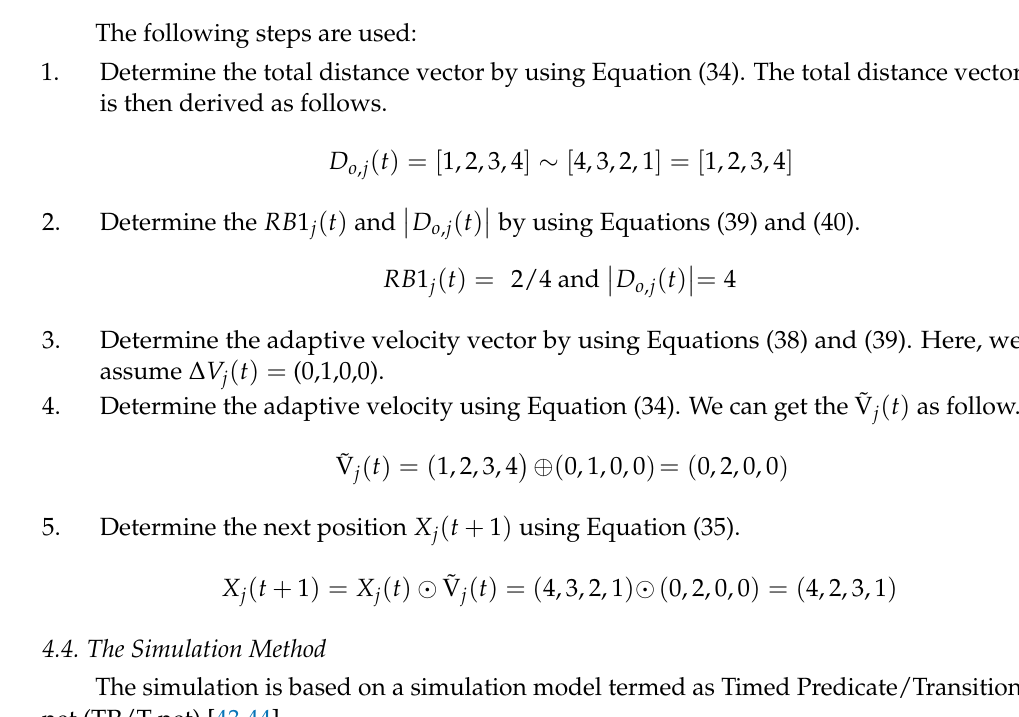
Figure 9. Particle i searches around the target particle o within a group.